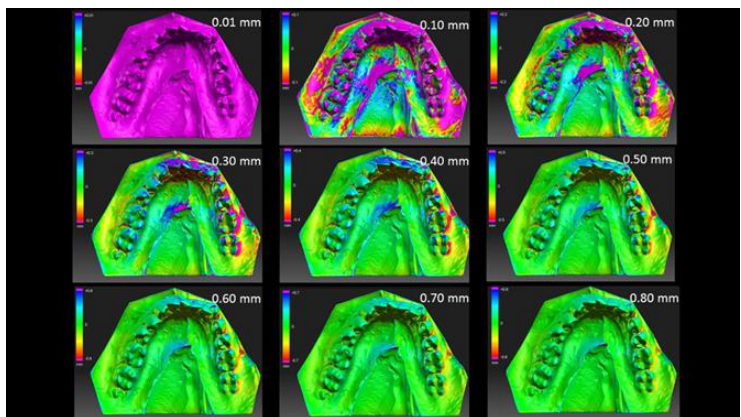
Figure 2. Maps of deviations prepared in accordance with the level of tolerance between 0.01 and 0.80 mm for sample number 1. Figure shows upon view areas where deviations are higher than the assumed level of tolerance as pink. Analysis was performed in three-dimensional perspective and the 0.80 mm level of tolerance was the lowest level without a deviation and are without pink areas.